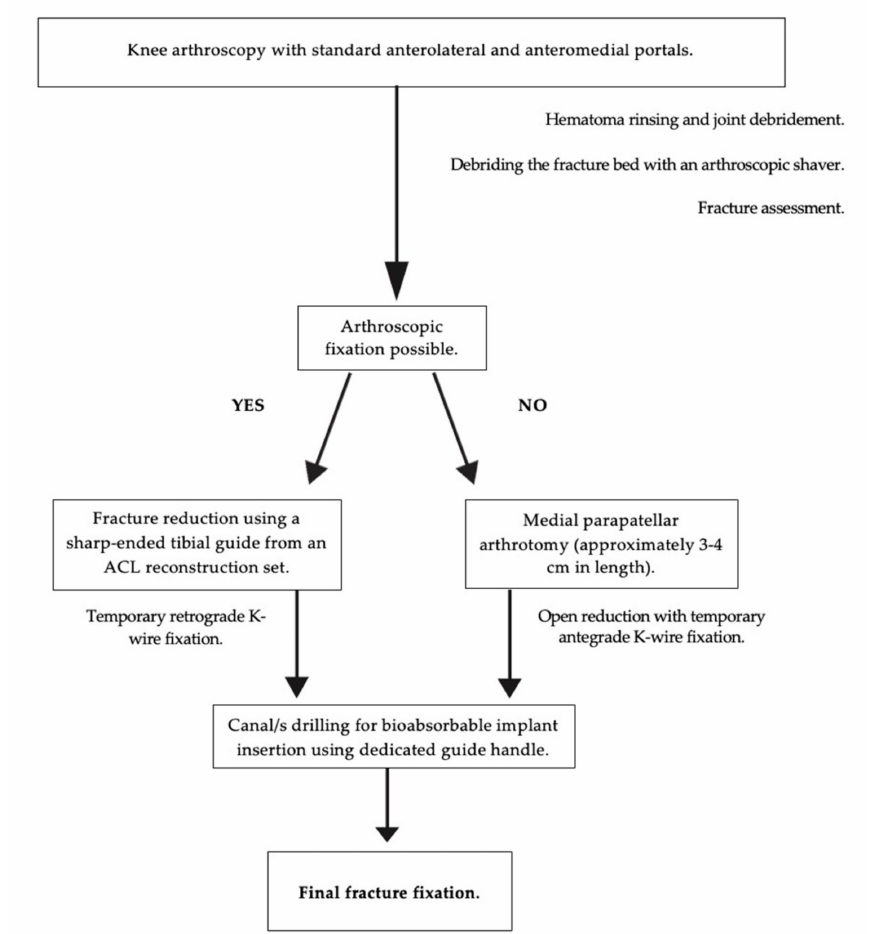
Figure 2. The diagram of the surgical procedure scheme. Postoperatively, the affected knee was immobilized in a plaster splint for four weeks.